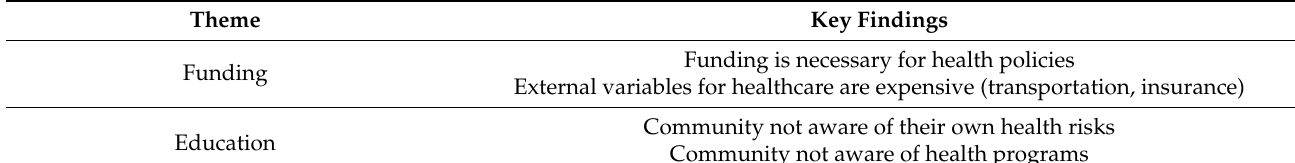
Table 2. Barriers of Public Health Identified by Kansas Public Health